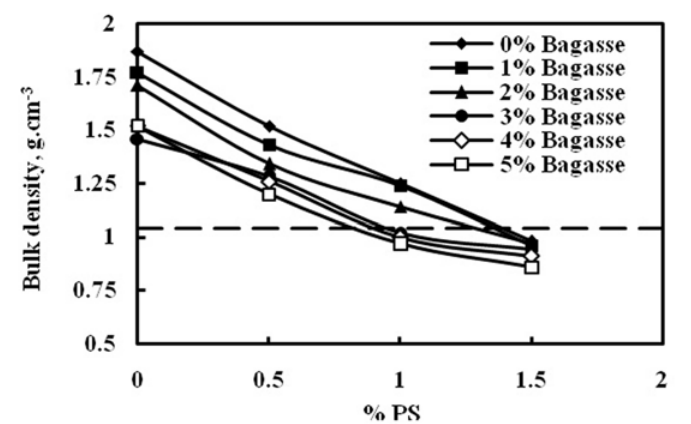
Figure 10. Effect of percent PS and Bagasse addition on bulk density